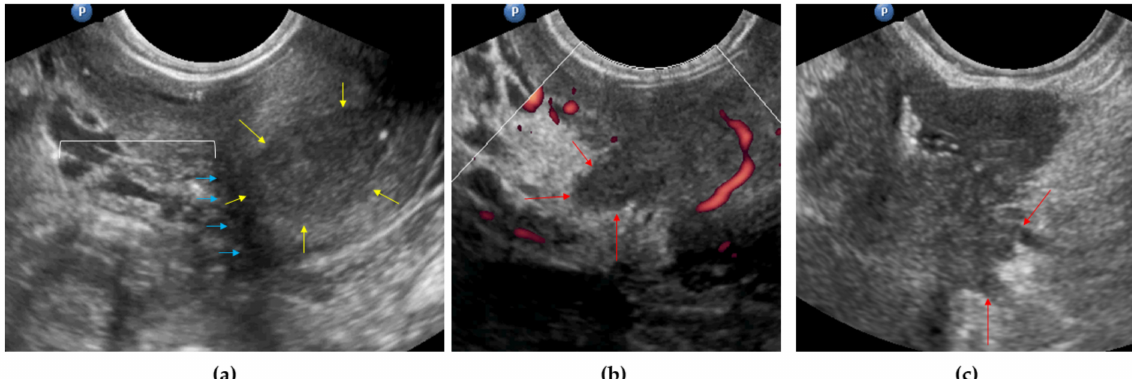
Figure 4. Lateral parametria assessment imaged using ultrasonography: ( a ) parametrium not involved (yellow arrows delineate the cervical tumor; blue arrows delineate the right lateral border of the cervix (not involved by the tumor); the white line represents the area of the lateral parametrium); ( b ) right parametrium involved (red arrows indicate the tumor prominence into the parametrium fat); ( c ) left lateral parametrium involved (red arrows indicate the tumor prominences into the parametrium